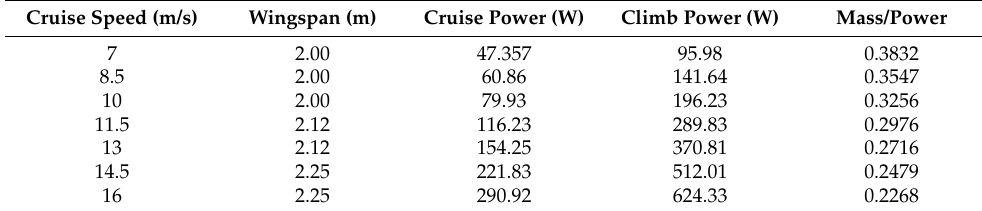
Figure 9. Mass/power ratio as a function of wingspan for different cruising speeds. Table 3. Main parameters of the aircraft for each cruise speed range.